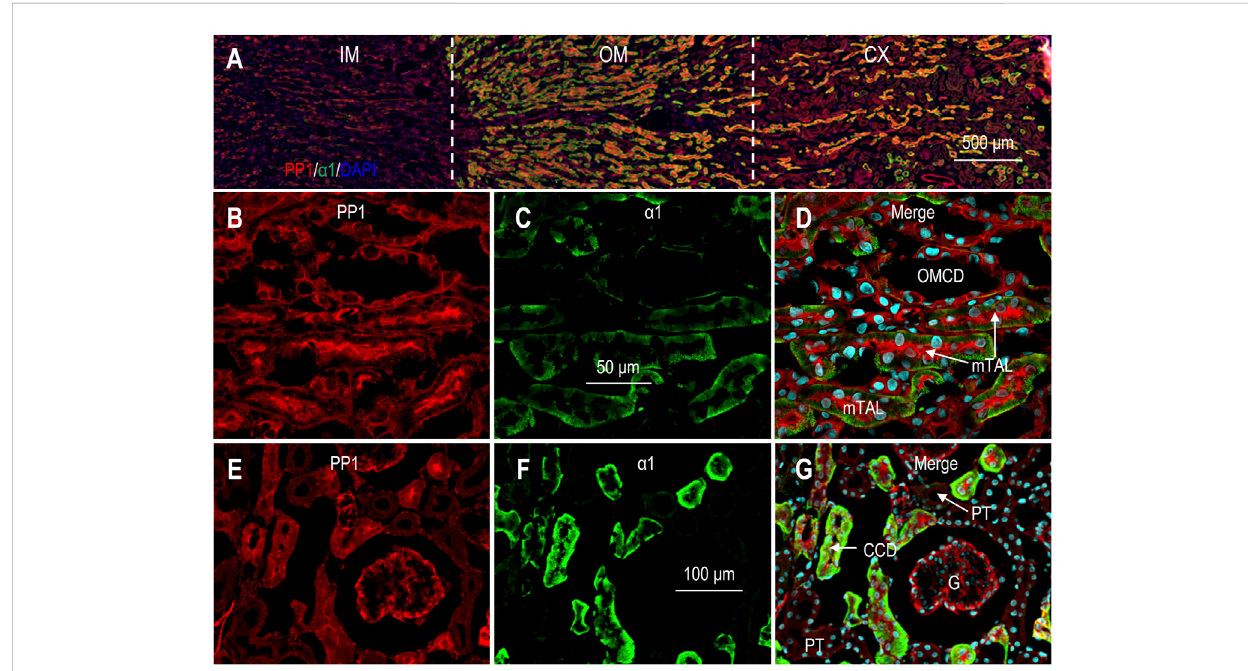
FIGURE 4 Indirect immuno fl uorescence of PP1 in rat kidney. (A) Merged overview of the double-staining of PP1 and α 1 in rat kidney. The original unmerged images of PP1 and α 1 were shown in Supplementary Figure S6. (B – D) Expression of PP1 and α 1 in out medulla. Strong fl uorescence signals of PP1 were observed in the mTAL and the OMCD. (E – G) Expression of PP1 and α 1 in cortex. Fluorescence signals of PP1 were observed in the glomerulus and the cortical collecting duct. G, glomerulus; CCD, cortical collecting duct; mTAL, medullary thick ascending limb; OMCD, outer medullary collecting duct.